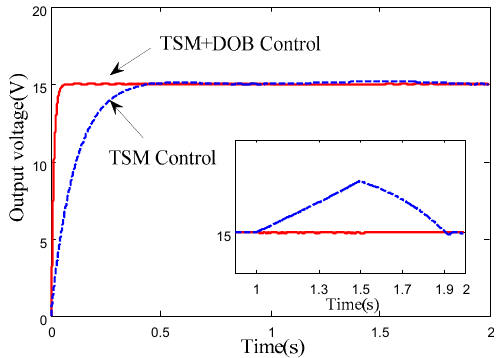
Energies 2018 , 11 , x Figure 6. Simulated step-input-voltage waveform of the output voltage. Figure 6. Simulated step ‐ input ‐ voltage waveform of the output voltage. Figure 6. Simulated step ‐ input ‐ voltage waveform of the output voltage.